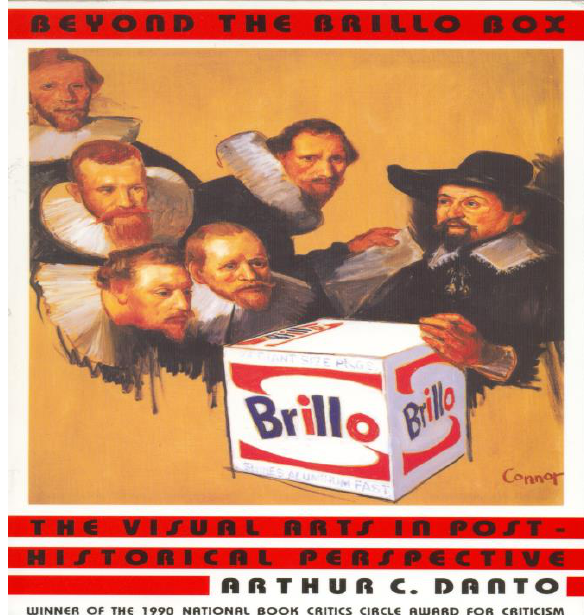
Fig.7: Cover image [by Russell Conner] for Danto´s book „Beyond the Brillo